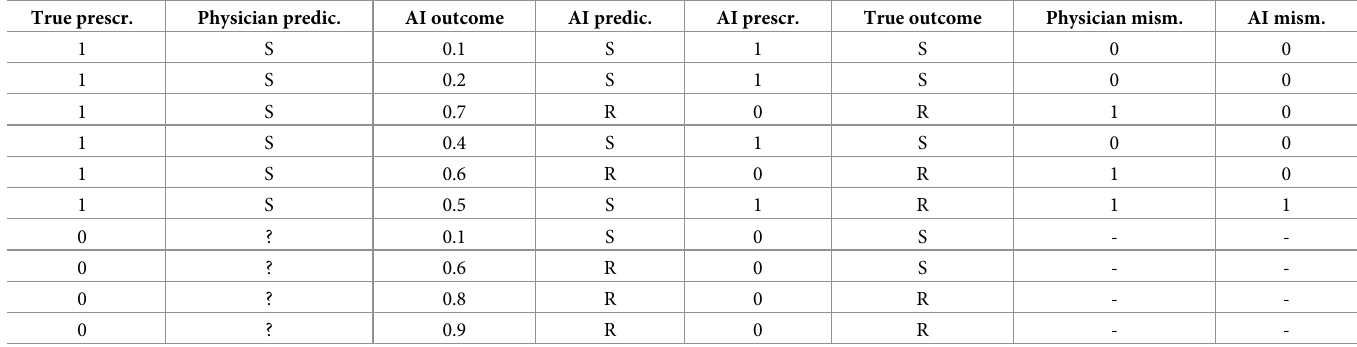
Table 4. Example of mismatched therapies and comparison between true and AI assisted prescriptions using strategy 1. For a given antimicrobial drug and inpatient, data contains prescription records (first column—1 if the drug was prescribed during admission, 0 otherwise), and later culture test (sixth column—“True outcome”, S or R if the isolate was found susceptible or resistant to the drug, respectively). In this example, 5 inpatients had resistant cultures, which defines n in the algorithm. Drug treat- ment corresponds to a physician’s prediction (second column—a physician prescribes a drug if they believe that isolates are susceptible to the drug, while nothing can be said if a drug is not prescribed). An AI system such as the GBDT model returns the probability that an isolate is found resistant (third column—“AI outcome”). The binary prediction is obtained by taking the n = 5 cases with the highest probability and assigning a label accordingly (AI prediction—fourth column). This suggests not to adminis- ter a drug if resistance is predicted (AI prescription—fifth column), thus lowering the total exposure to the drug (from 6 to 4 inpatients under treatment). By comparing the true prescription or the AI prescription (columns 1 and 5) with the culture test results (column 6) the number of mismatches can be computed (7th and 8th columns for the physician and AI assisted prediction,